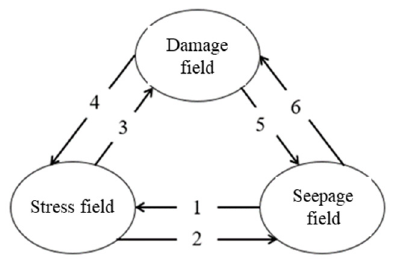
Figure 6. Stress–seepage–damage coupling interaction mode.